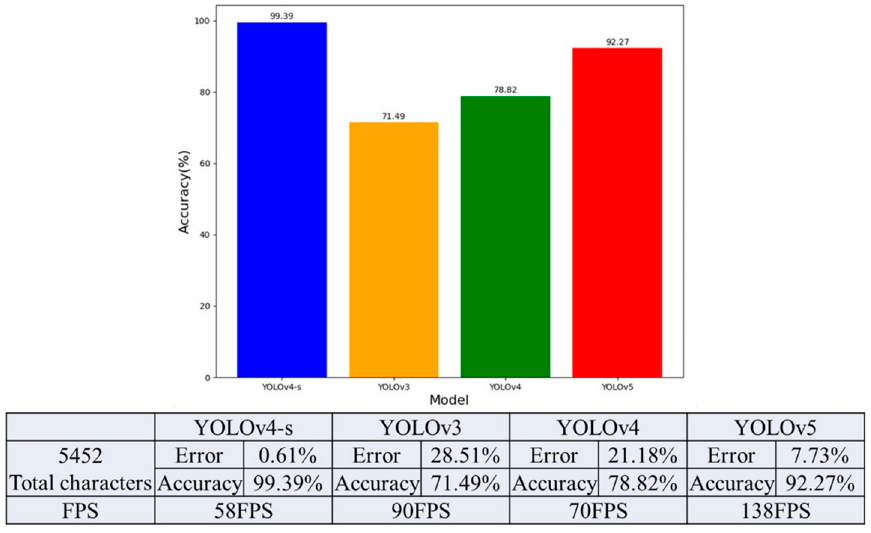
Figure 20. Comparison of recognition accuracy of various methods .